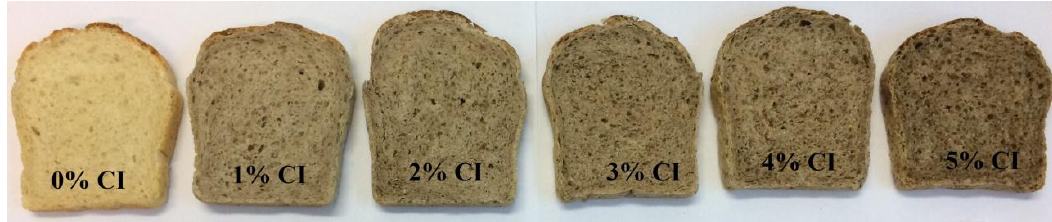
Figure 1. Appearance of wheat bread with different amount of Cistus incanus L (CI).